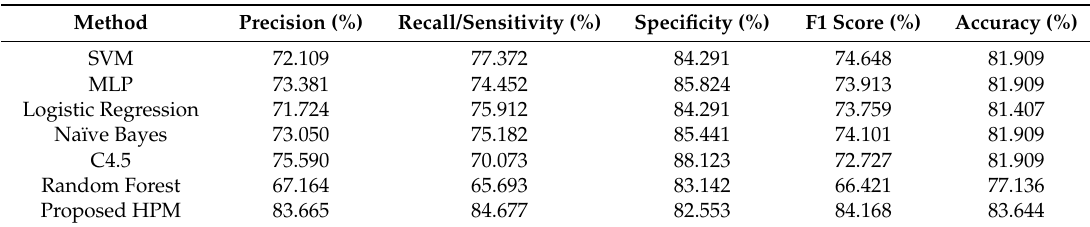
Table 10. Performance evaluation of classification model for dataset